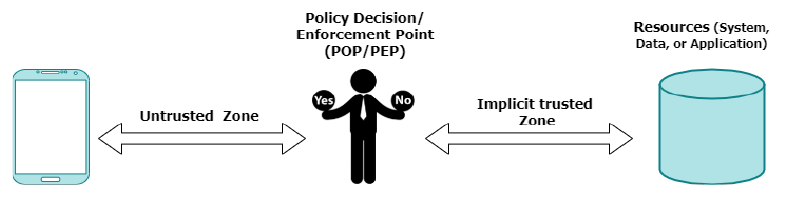
Figure 5. Zero trust resource access.